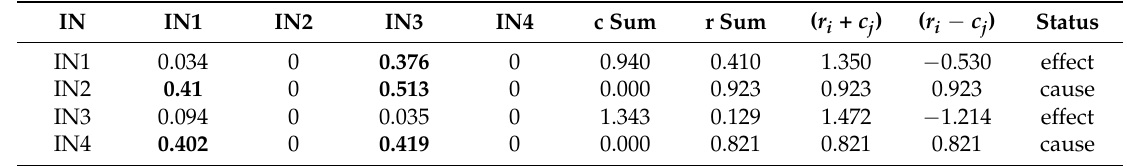
Table 7. The total relation matrix for Instrumentation and Control system FMs.